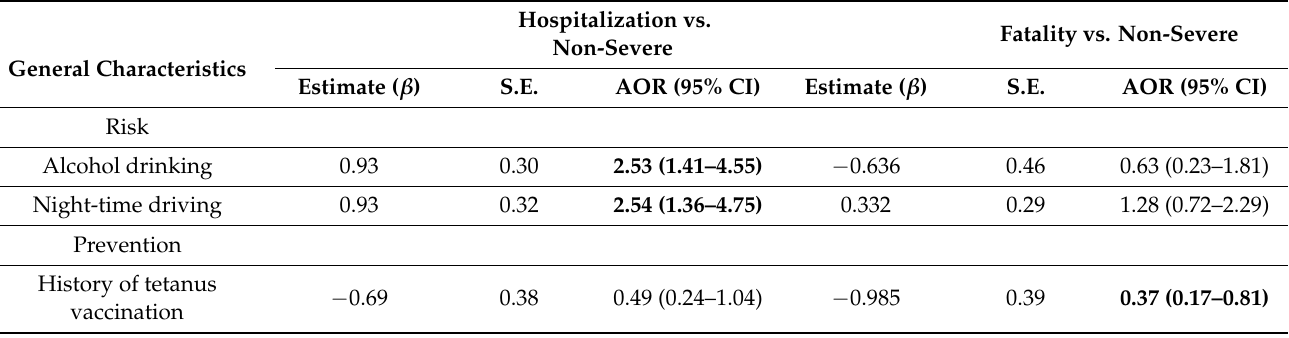
Table 4. Adjusted odds ratio (AOR) for each factor comparing levels of outcome severity at the Burapha University Hospital emergency